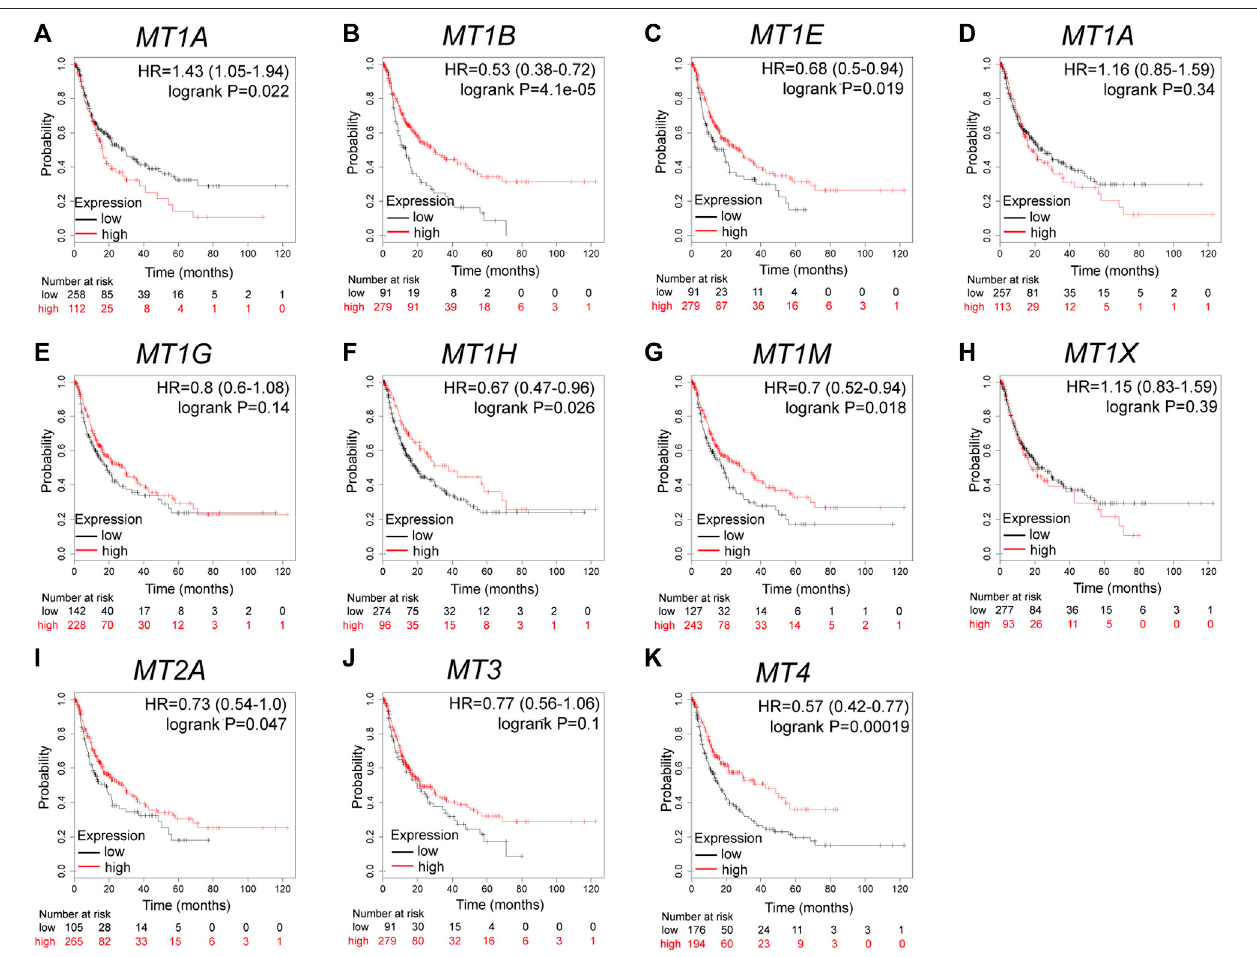
FIGURE 5 | Prognostic values of speci fi c MT isoforms in HCC: (A – K) PFS in Kaplan – Meier plotter. The p -values were calculated by the log-rank test. PFS, progression-free survival.